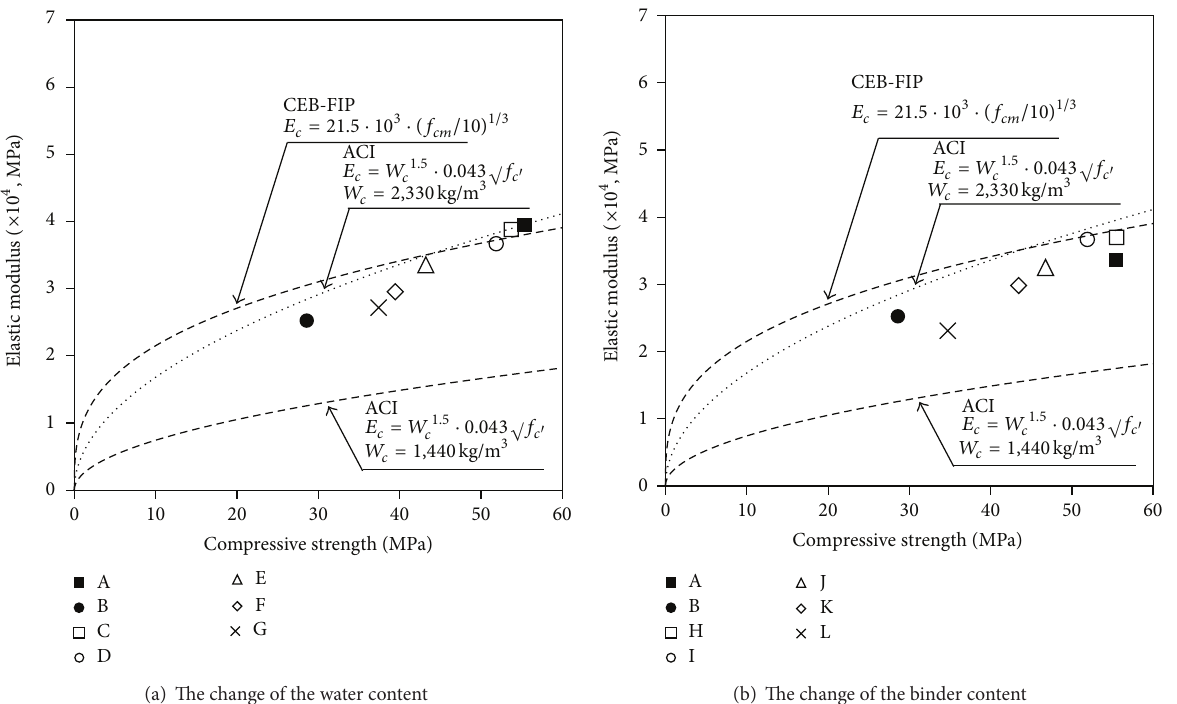
Figure 5: The relationship with the compressive strength and coefficient of elasticity of high volume fly ash